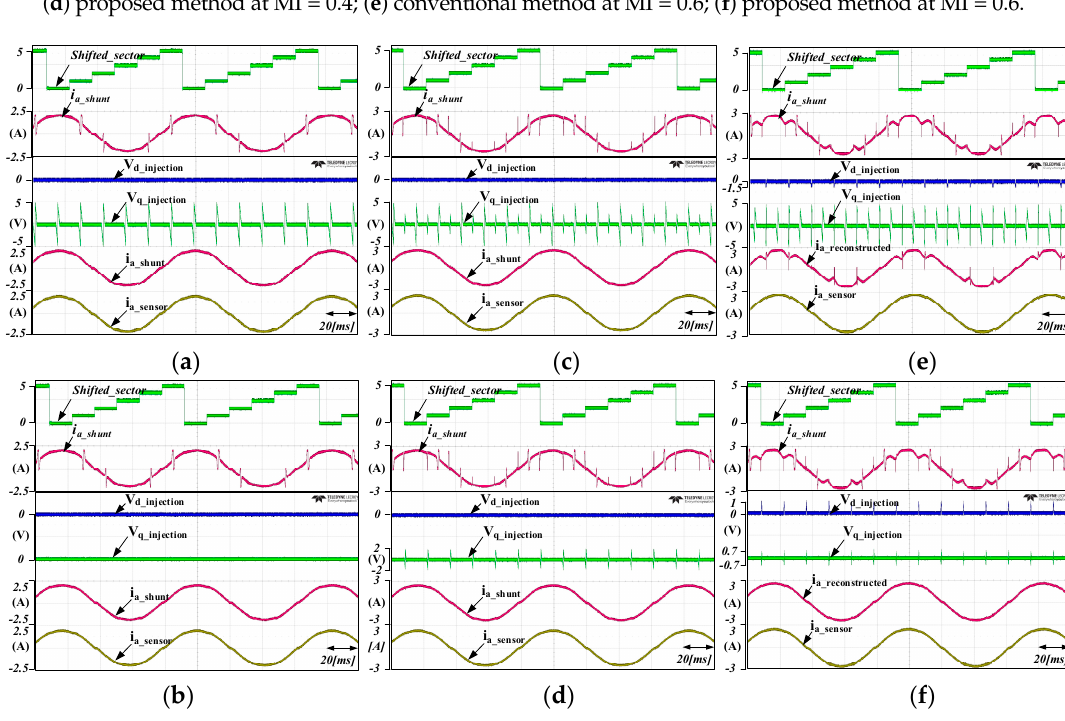
Figure 25. Comparison of the conventional and proposed methods at MI = 0.8, 0.9, and 0.97. ( a ) Conventional method at MI = 0.8; ( b ) proposed method at MI = 0.8; ( c ) conventional method at MI = 0.9; ( d ) proposed method at MI = 0.9; ( e ) conventional method at MI = 0.97; ( f ) proposed method at MI = 0.97.